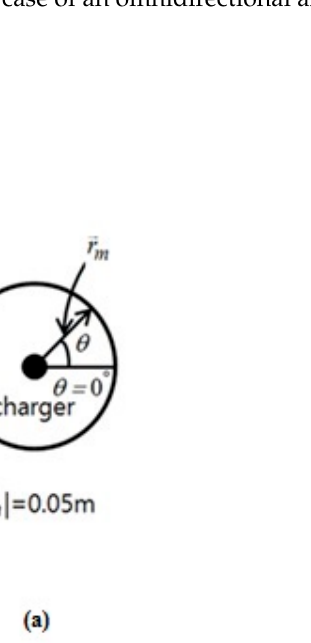
Figure 4. Next location circle and service sector for charging undercharged cluster heads: ( a ) next location circle; and ( b ) sectors including undercharged cluster heads.